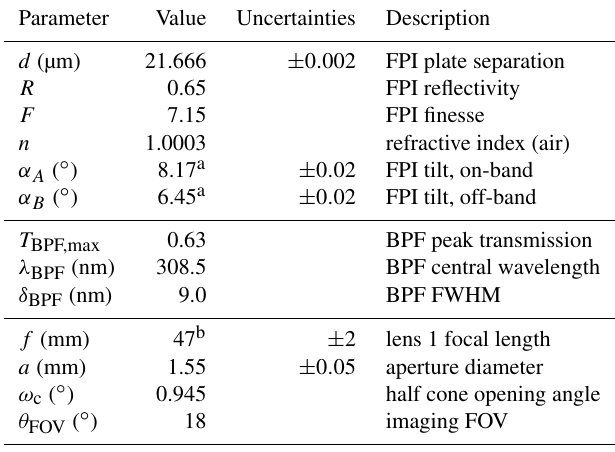
Table 1. Parameters of the optical components installed in the IFPICS prototype and used in the calibration model. The uncertainties of the model input parameters are shown.